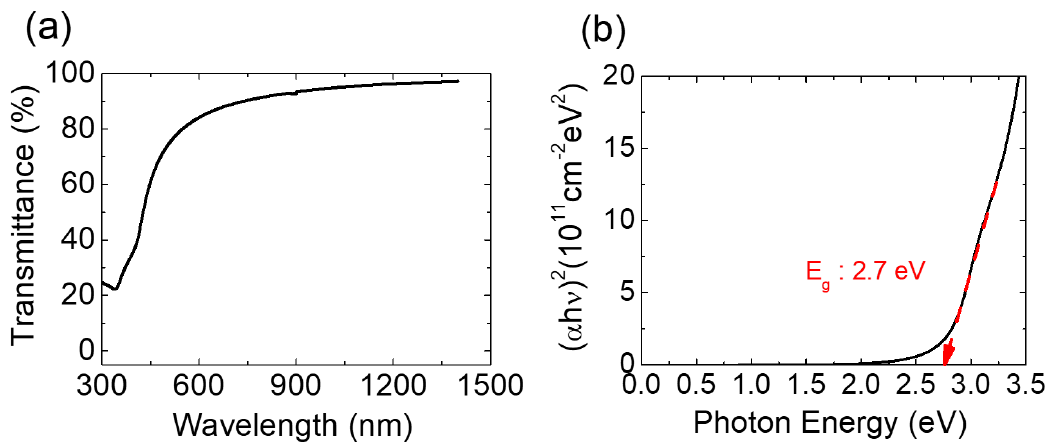
Figure 4. ( a ) Optical transmittance spectra of the SnO X thin film; ( b ) Tauc plot calculated from the measured optical transmittance spectra.